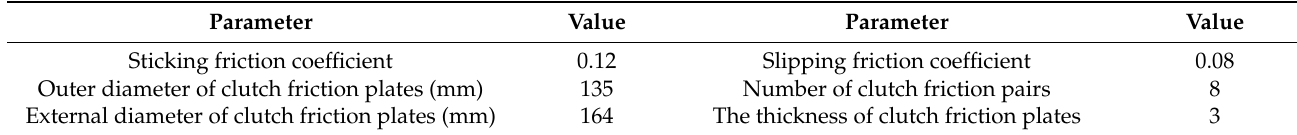
Figure 5. Test bench to verify the simulation test platform based on SimulationX. It includes the: ① engine, ② transmission assembly, ③ pump – motor system, ④ rotating speed – torque sensor, ⑤ electric eddy current dynamometer, and ⑥ hydraulic control system. Table 1. Simulation Parameters of wet clutch oil filling test platform.